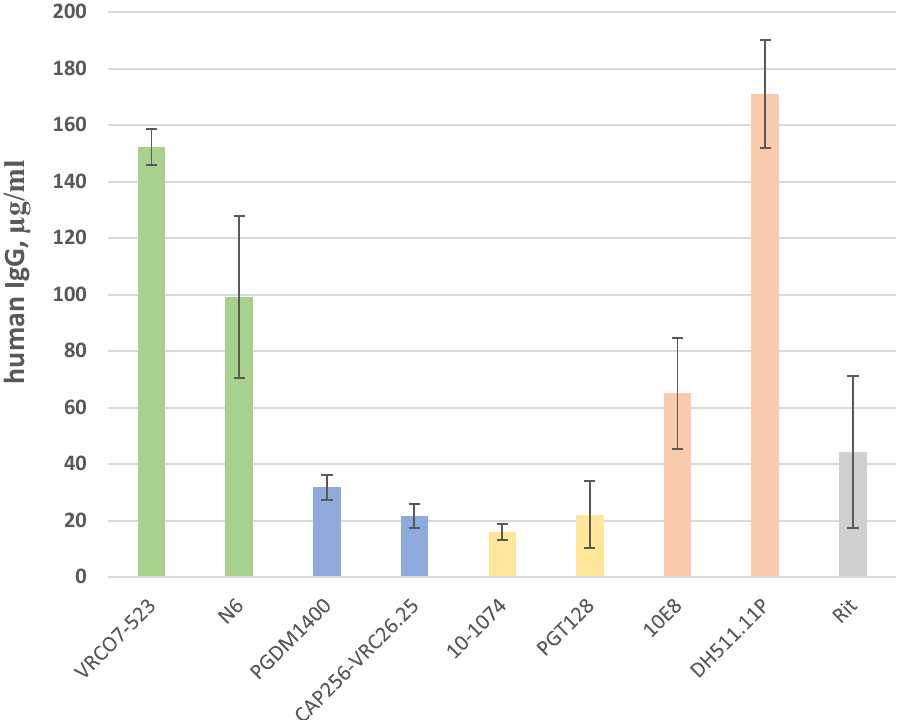
Figure 2. Antibody concentration (ELISA, total human IgG) (n = 3, ± SEM). Antibody production in the medium was also confirmed by a Western blot with poly- clonal antibodies against human IgG. For most antibodies, we detected two bands that corresponded to the expected molecular weights of the heavy and light chains. Unex- pectedly, analysis of the CAP256-VRC26.25 antibody showed an additional band with a